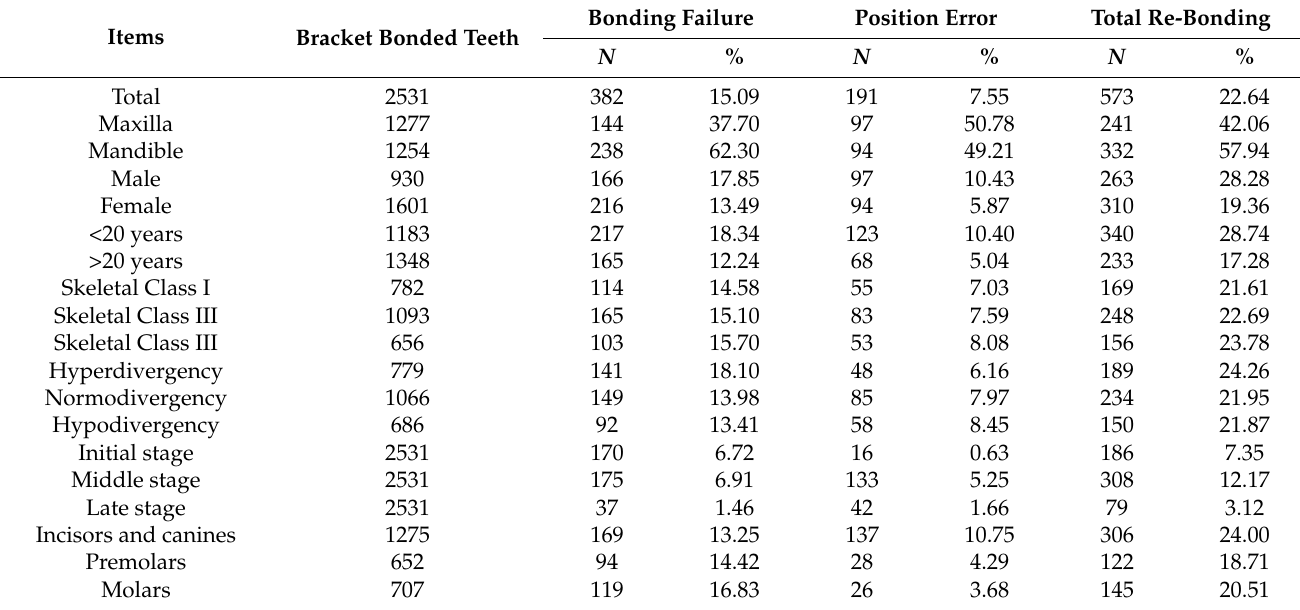
Table 1. Descriptive statistics of bracket re-bonding rate.